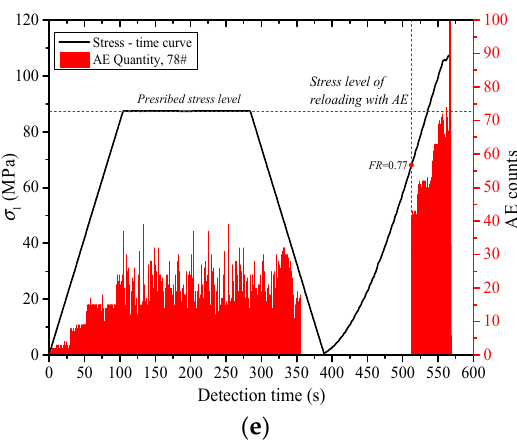
Figure 6. Stress–time–AE curves in uniaxial cyclic loading and unloading test of granite under different stress levels. ( a ) σ A = 0.5 σ c ; ( b ) σ A = 0.6 σ c ; ( c ) σ A = 0.7 σ c ; ( d ) σ A = 0.8 σ c ; ( e ) σ A = 0.9 σ c .